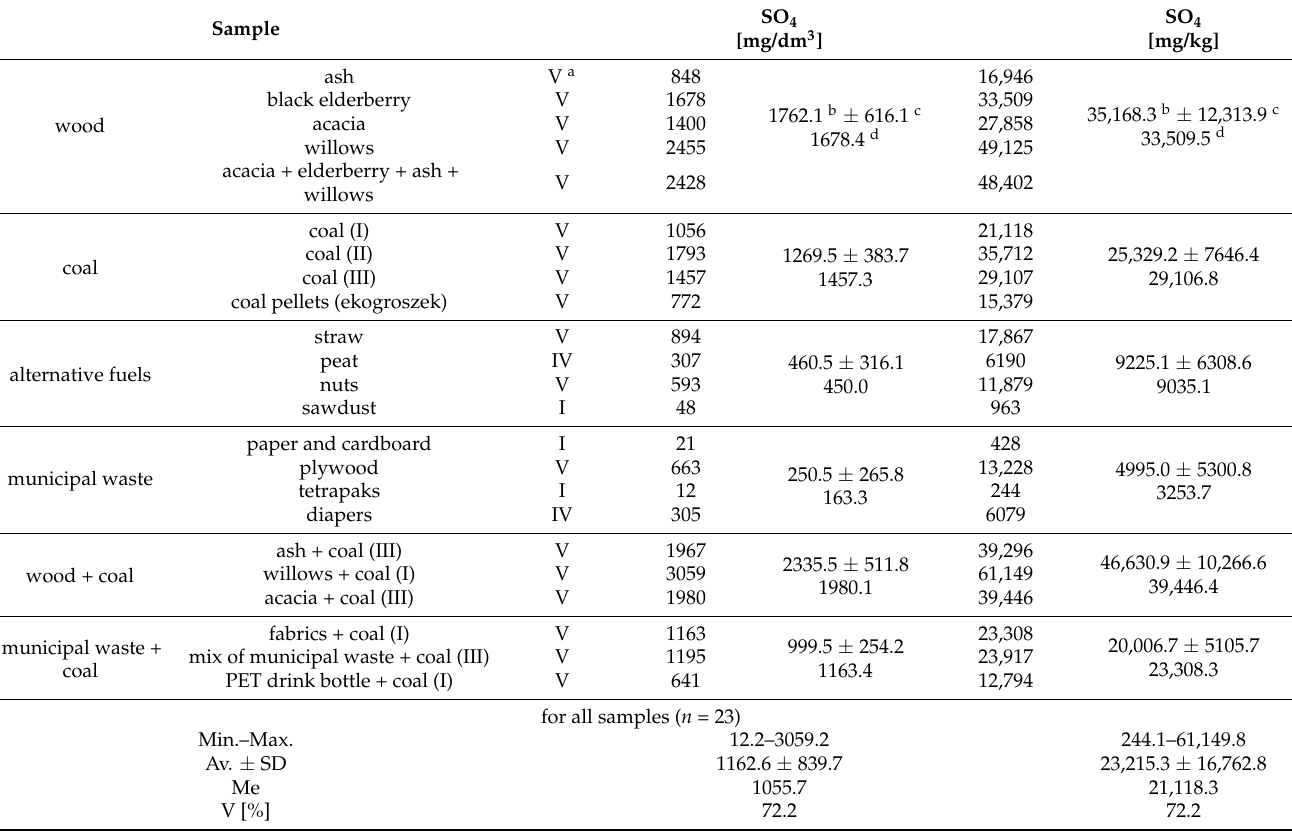
Table 3. Statistical parameters for water leaching of sulphide from